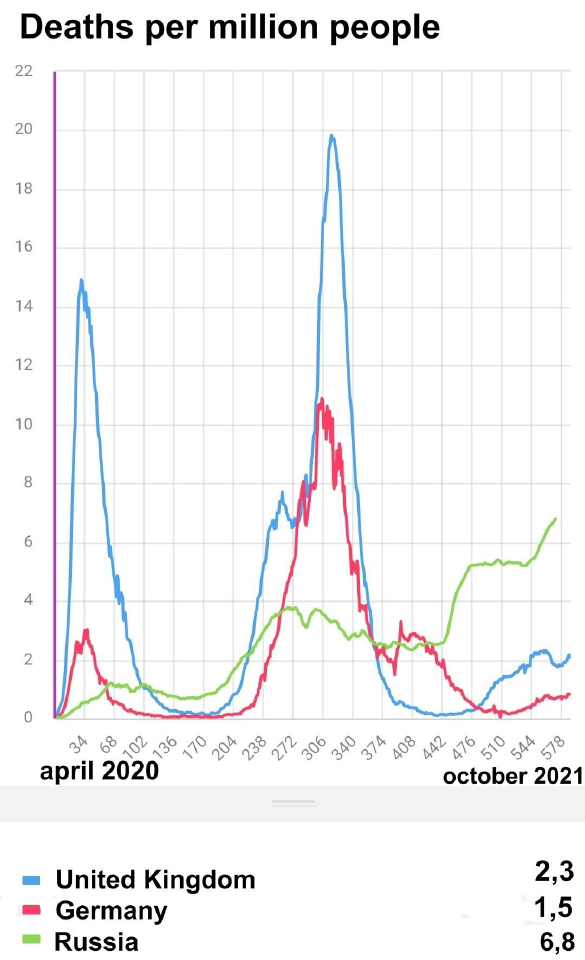
Figure 11. Deaths per million following national vaccination pro- grams. Blue line - Great Britain (74% of the vaccinated population), pink – Germany (69% of the vaccinated population), green – Russia (35% of the vaccinated population). The relative mortality in each country is marked with numbers (at the beginning of November